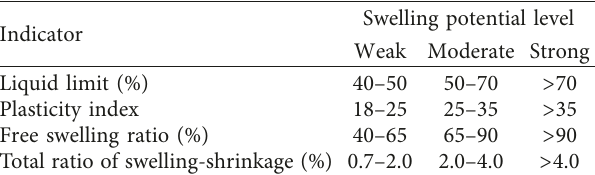
Table 2: Classification indicators of expansive